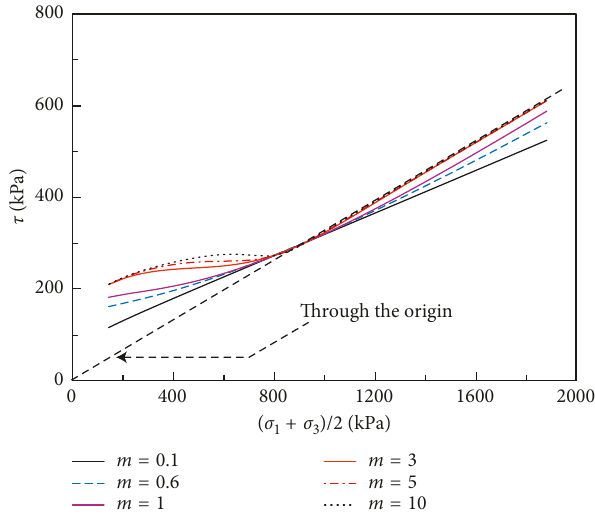
Figure 8: Influence of parameter m to evolution laws of shear strength.